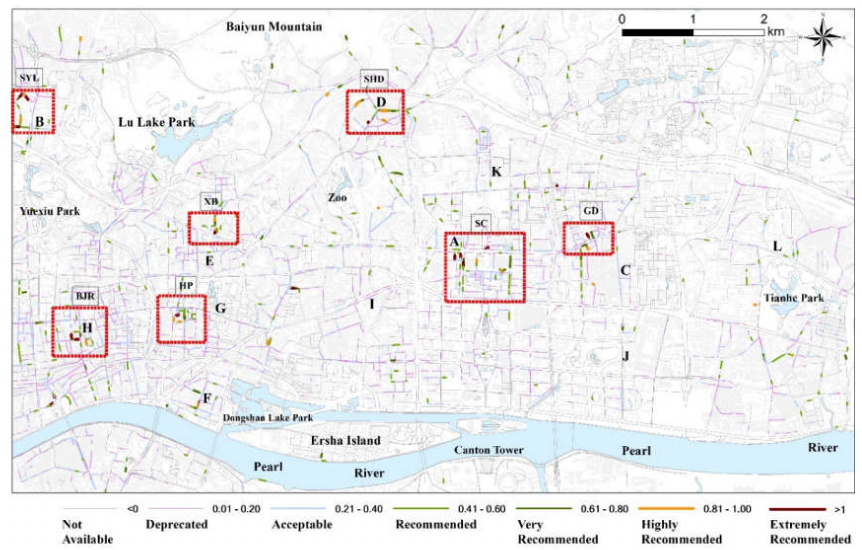
Figure 5. Results of the shopping walking index (SWI). SYL: Sanyuanli Business District;